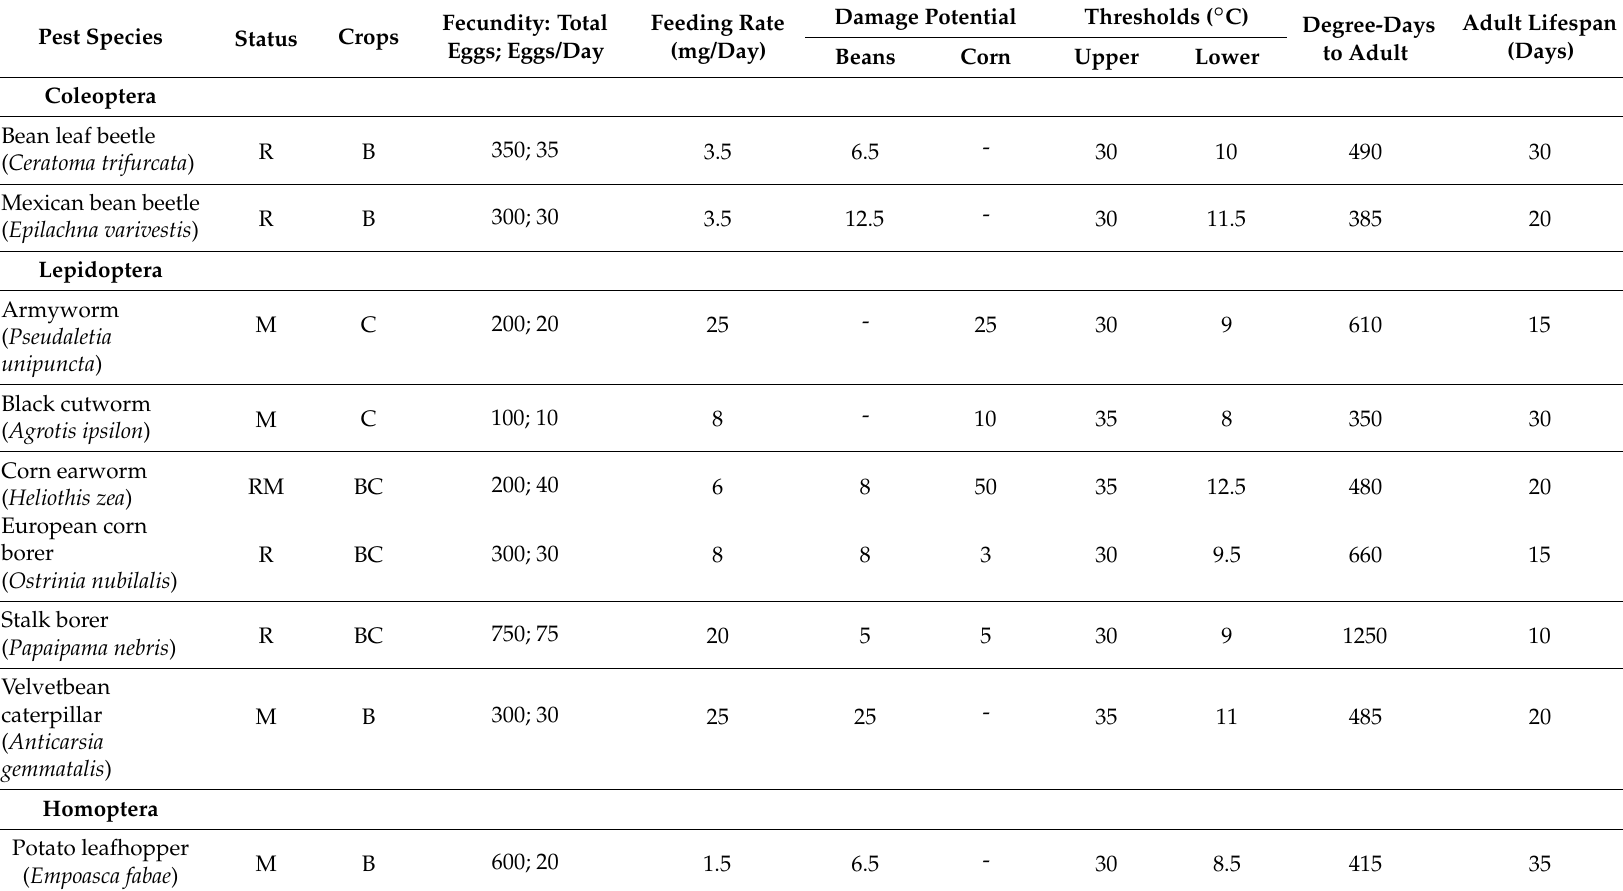
Table 1. Insect life history characteristics programmed into the Generalized Insect Life-SYstem Model